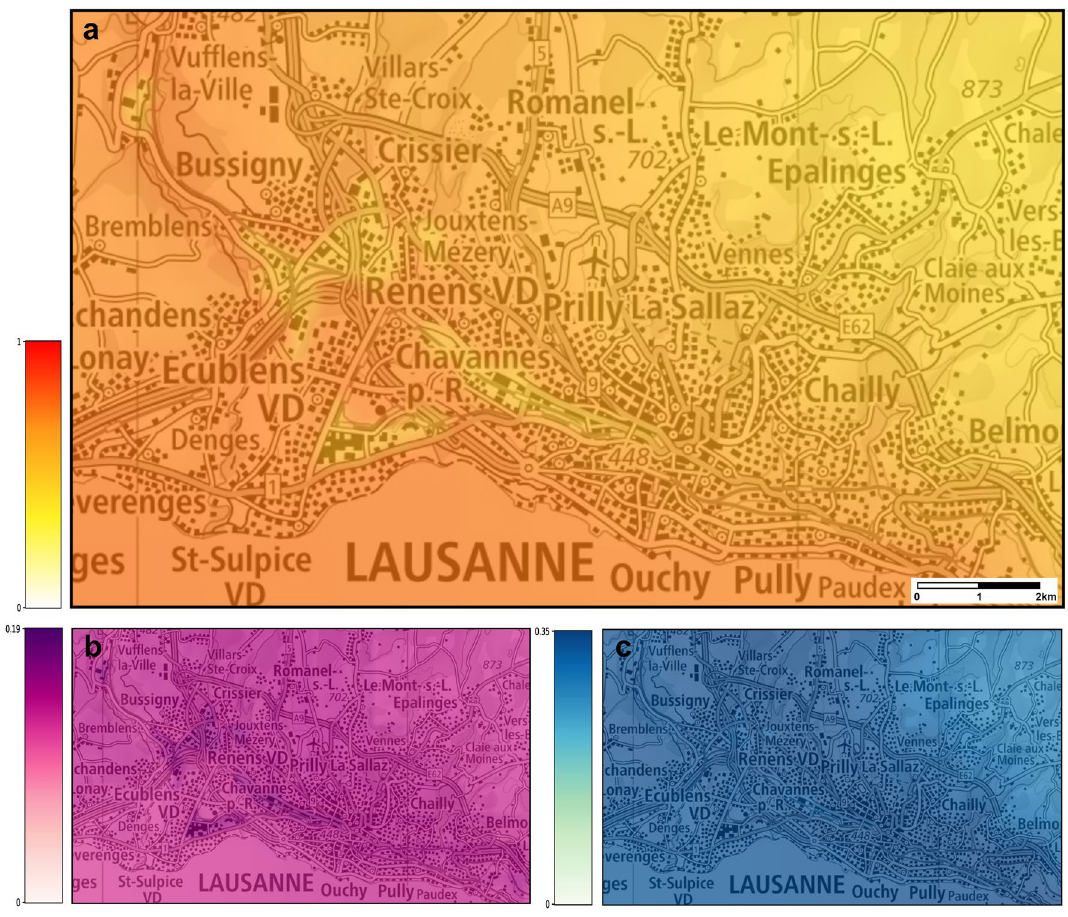
Figure 6. ( a ) Probabilities of establishment of Ae. albopictus in Lausanne using the temperatures corrected with the microclimatic model. The map shows the average risk estimate over the years 2015–2018. The color gradient shows the probability of establishment from 0 (white) to 1 (red). ( b ) Uncertainty of prediction (higher values representing more uncertain predictions). ( c ) The difference between the risk estimates obtained using the original temperatures and the transformed ones. Maps modified from https:// map. geoad min. ch/ (accessed on 1 April